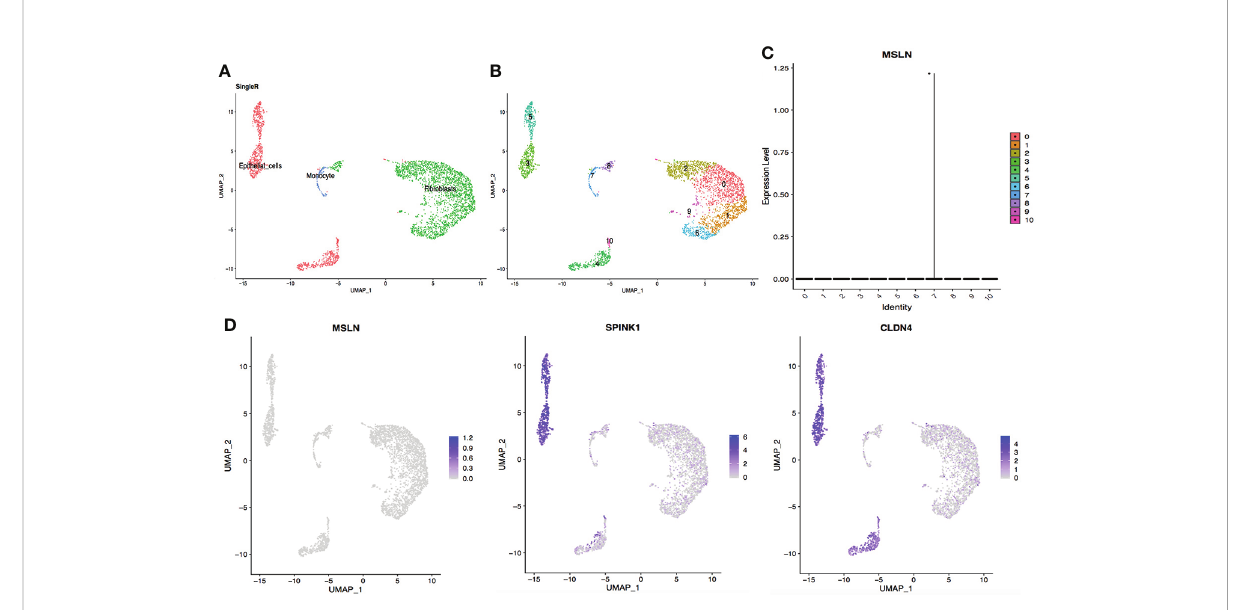
FIGURE 8 ScRNA-seq data analysis showing bladder urothelial cells with low MSLN expression. (A) Cell types in the bladder according to SingleR. (B) Cells in the bladder were categorized into 11 different clusters, numbered 0 to 10. (C) Violin plot of MSLN expression distribution in these 11 different cell clusters. (D) Scatter plots showing that the cluster of cells with MSLN expression also expressed the typical bladder urothelial cells markers SPINK1 and